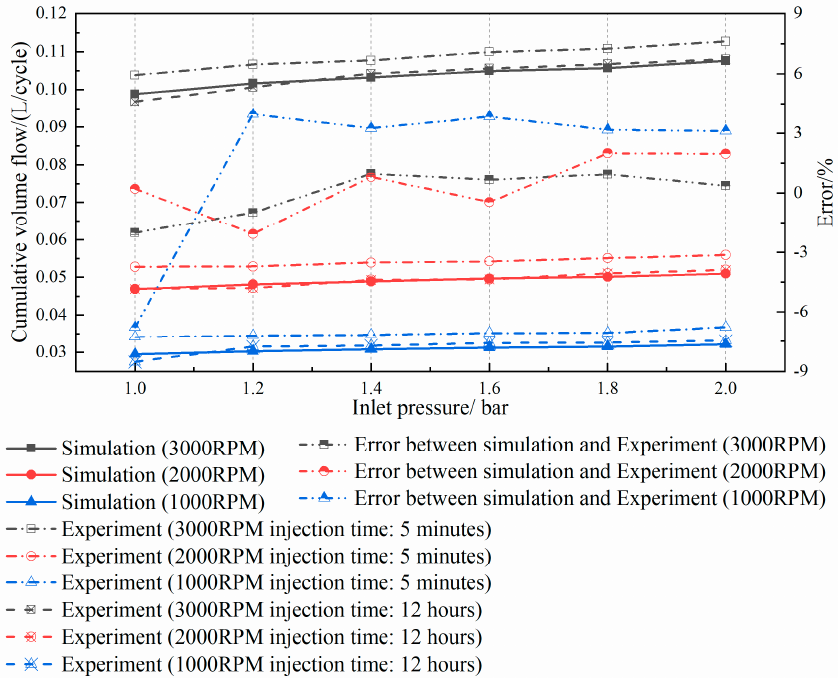
Figure 5. Comparison of single conversion and single-cycle transient volume